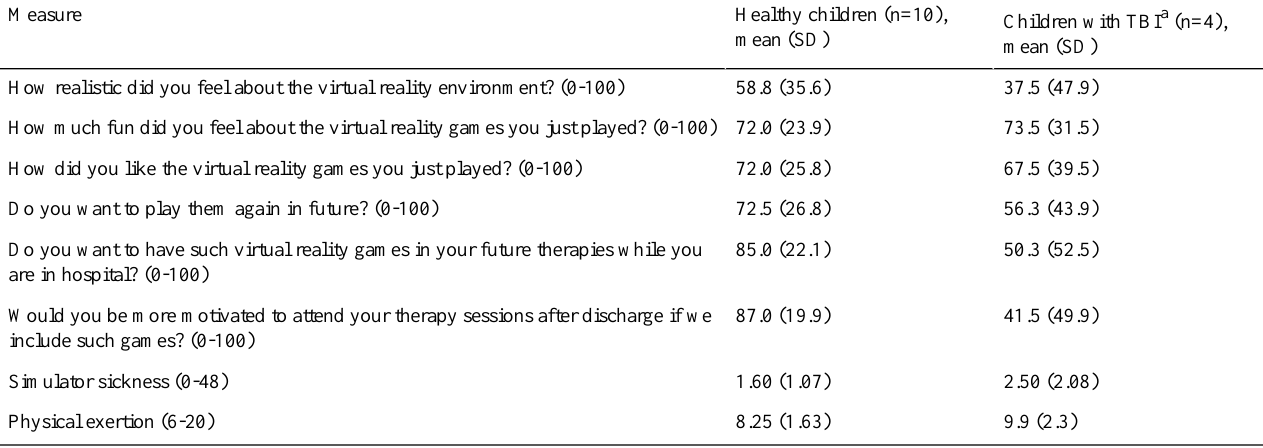
Table 3. Usability findings in healthy children and children with traumatic brain injury.